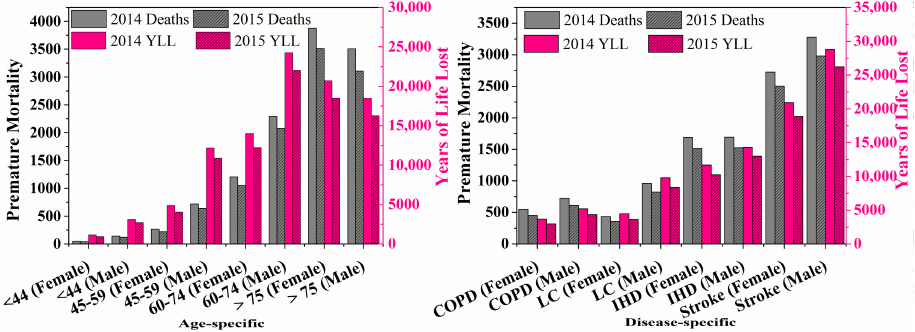
Figure 4. Premature mortality and years of life lost attributable to PM 2.5 in Nanjing.